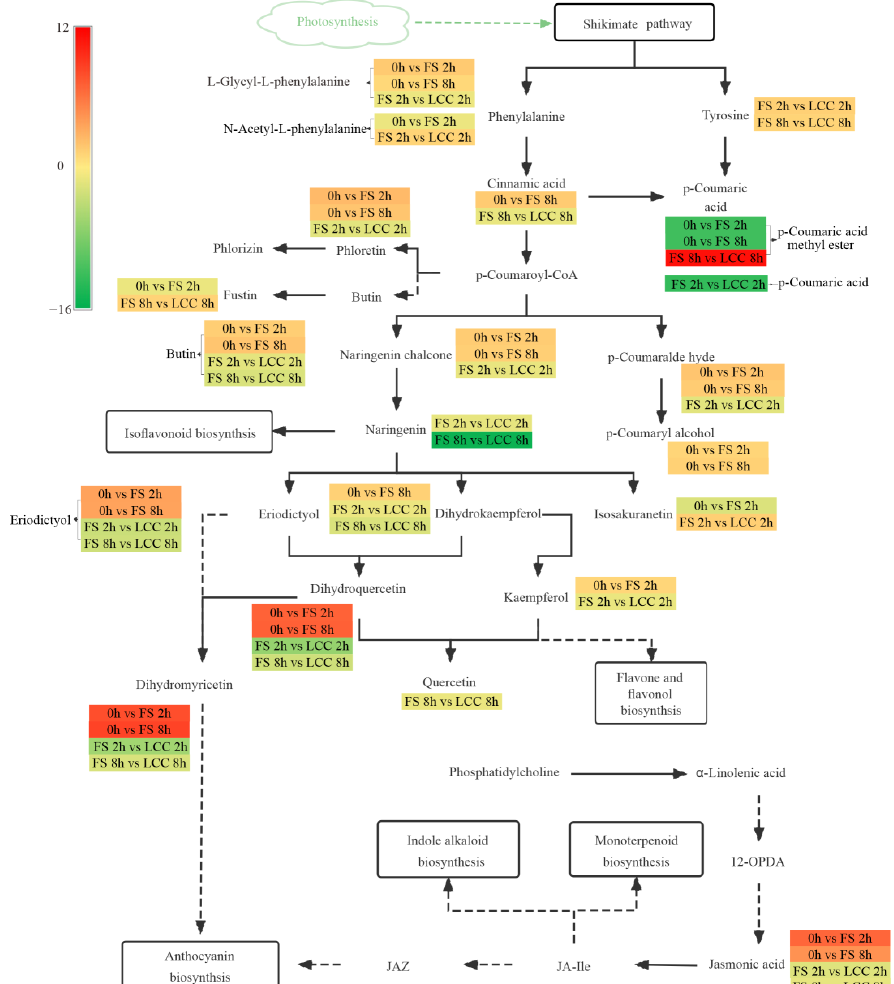
Figure 7. Pathway and expression of flavonoids, phenylpropanoids, and JA with different accumulations. The blocks are the log 2 FC of the response substances, and the color indicates the expression level. Solid lines show the reaction with no intermediate steps, and dashed lines show the reactions requiring an intermediate process.